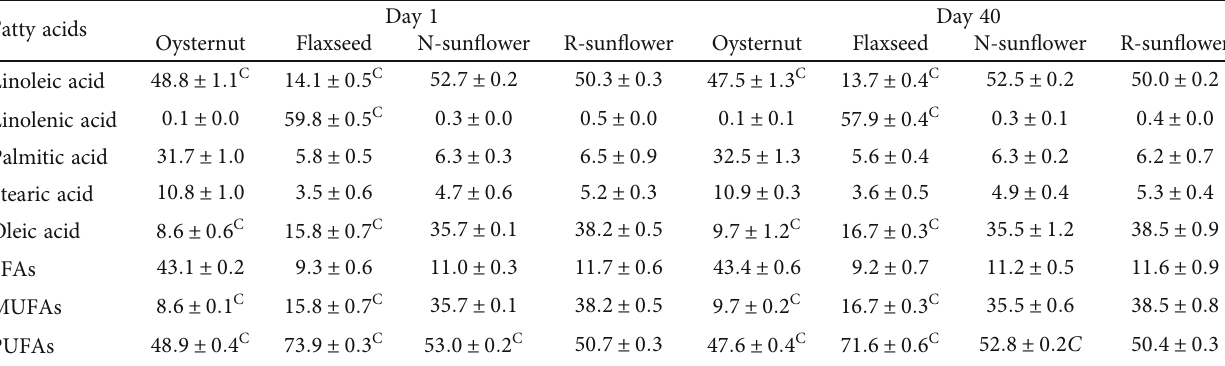
Table 1: Average ( ± SD) of the major fatty acid contents (%) of oyster nuts oil, fl axseed oil, nonre fi ned sun fl ower oil, and re fi ned sun fl ower oil measured at day 1 and after 40 days of storage at 27 ° C. Fatty acids